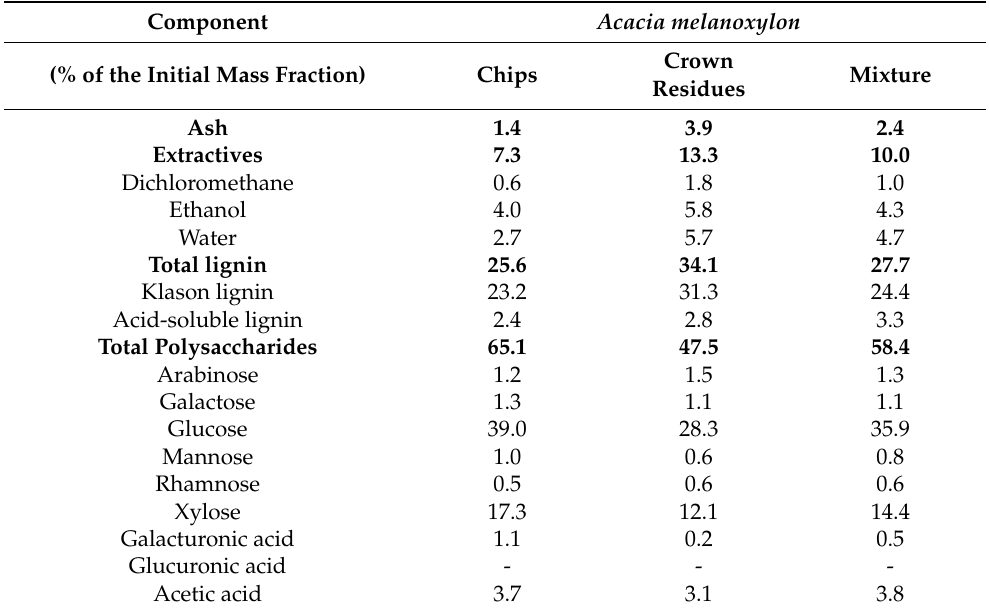
Table 1. Chemical Composition of chips (wood and bark), crown residues (branches and leaves), and a mixture of chips and crown residues of Acacia melanoxylon trees. (Average of 3 repetitions per